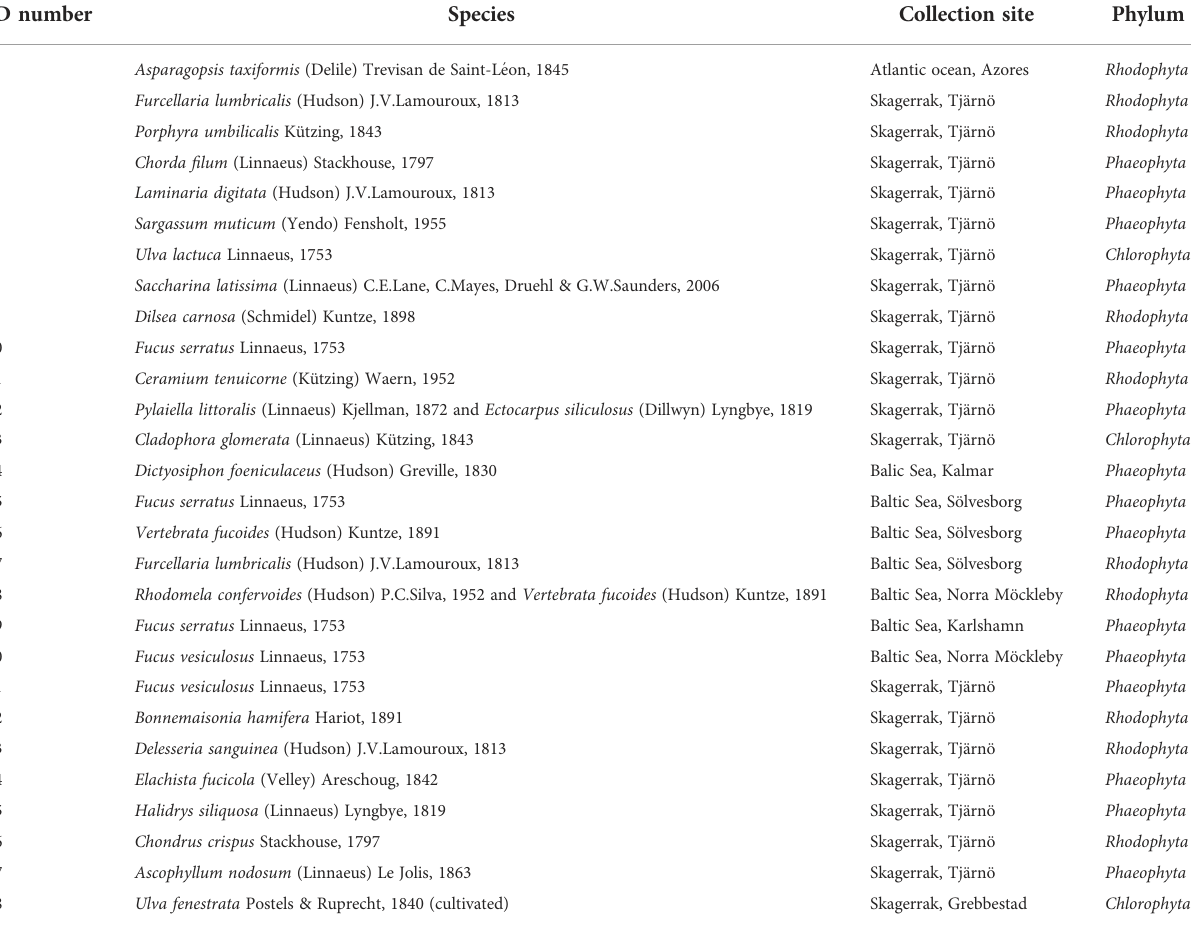
TABLE 1 Swedish seaweeds and Asparagopsis taxiformis (positive control) screened in vitro for CH 4 mitigating effect. ID